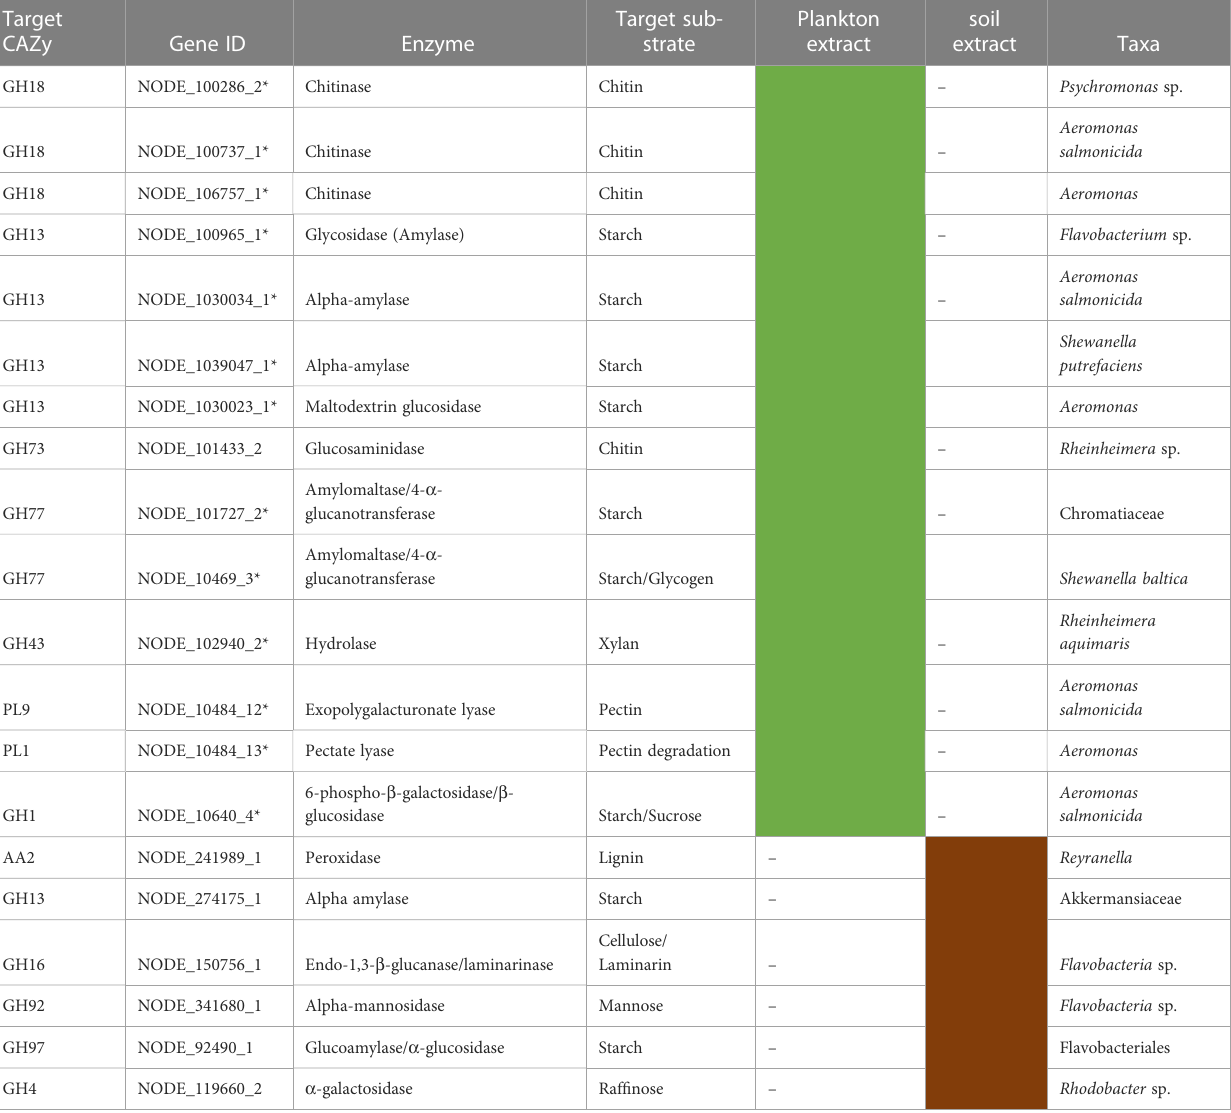
TABLE 3 List of selected enriched genes coding for carbohydrate active enzymes (CAZymes) induced by addition of plankton extract and soil